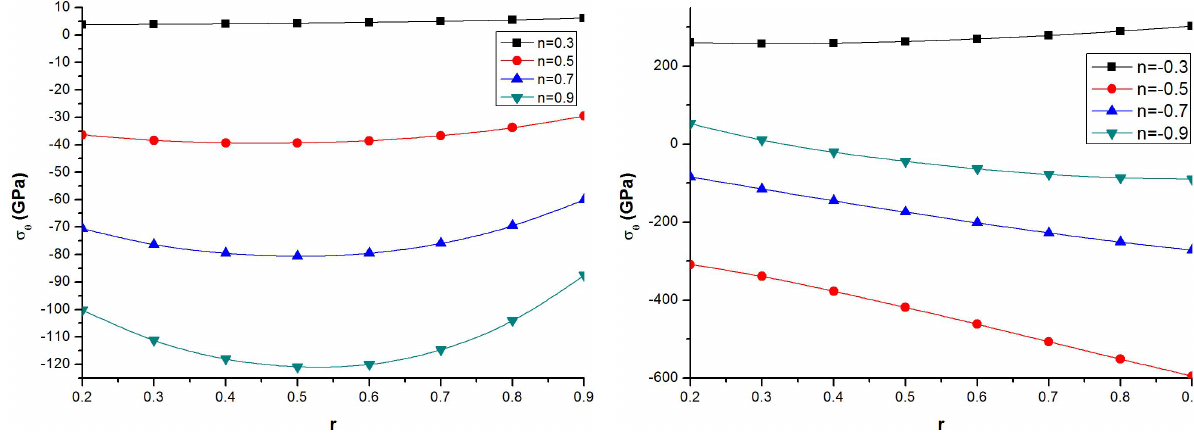
Figure 9: Circumferential stress versus radial coordinate for various values of n under steady state temperate distribution